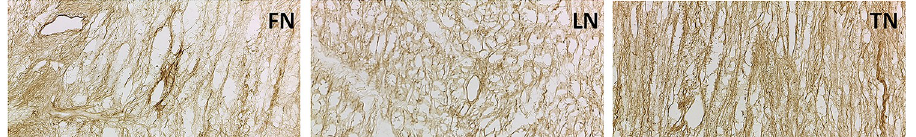
PLOS ONE | https://doi.org/10.1371/journal.pone.0276224 October 19,